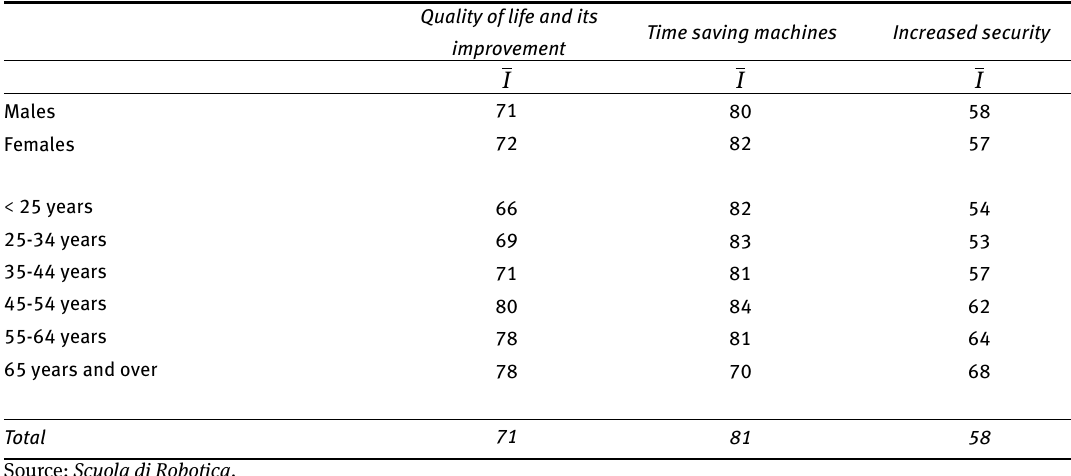
Table 7: Spreading of robots in the society and welfare, time saving and safety. Trust index*. Quality of life and its